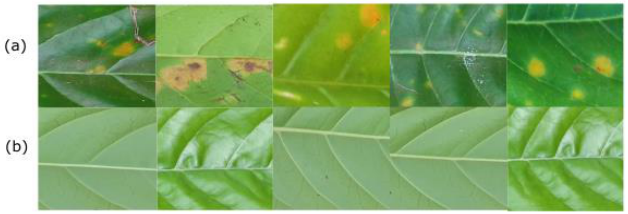
Figure 7. This figure shows a sample image of extracted patches. ( a ) non-healthy patch image; ( b ) healthy patch.